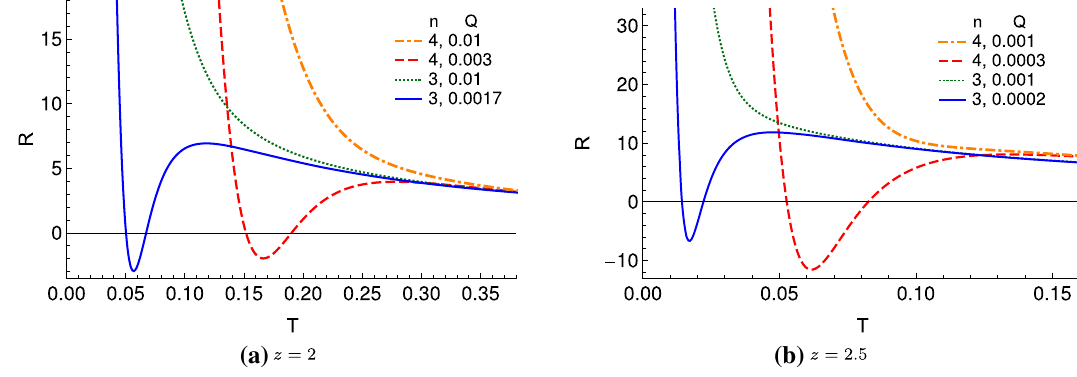
Fig. 7 The behavior of the Ruppeiner invariant R versus T for the linear Maxwell case with l = b = 1